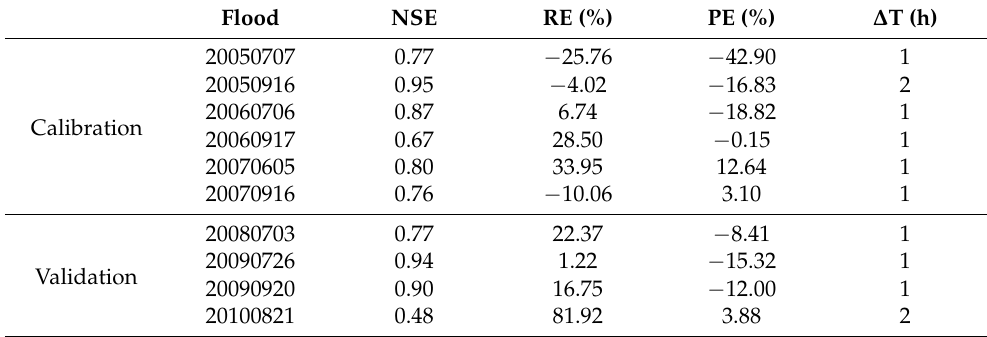
Table 5. Simulation results of the coupled